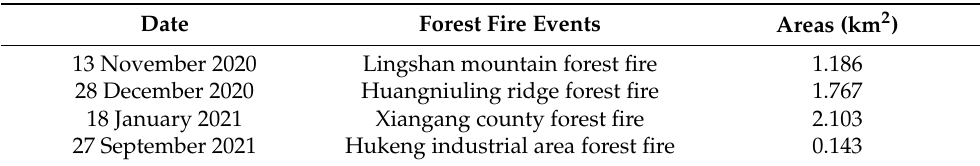
Table 1. Overview of the four forest fire events in Zhaoqing.